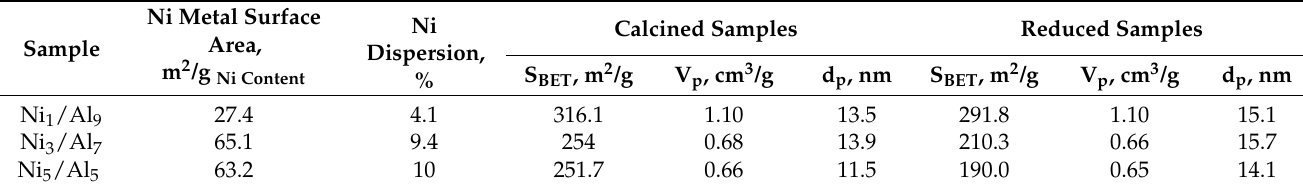
Table 2. Physicochemical properties of the NiAl 2 O 4 catalysts with various Ni/Al ratios.